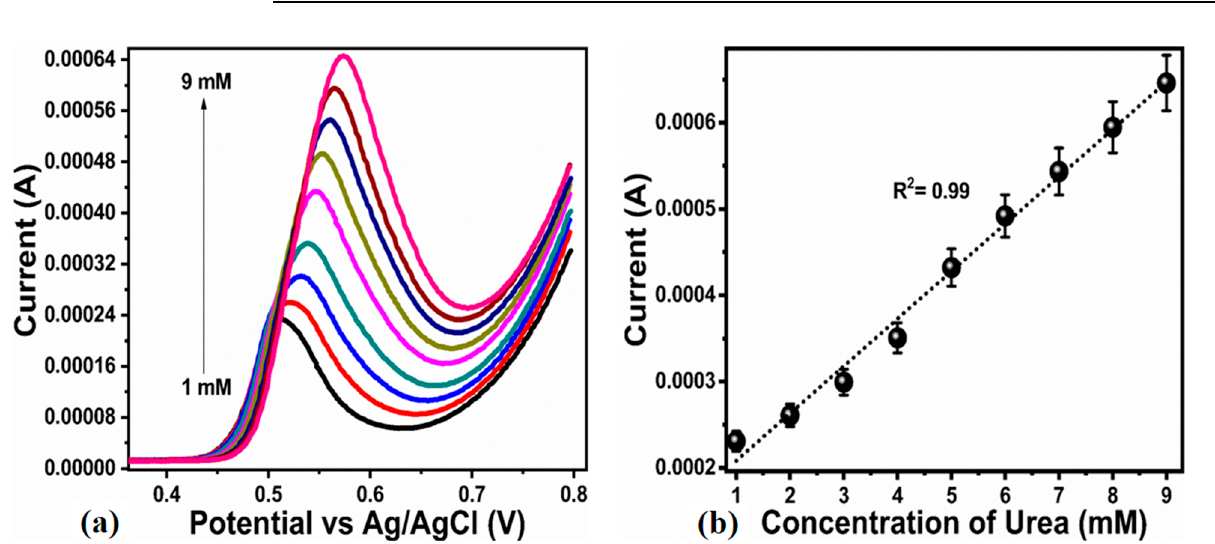
Figure 4. ( a ) Cyclic voltammogram of sample 1 prepared with 10 mL of bi tt er gourd peel extract at v50 mV/s in various urea concentrations ranging from 1–9 mM, ( b ) linear plot of peak current versus urea concentrations.